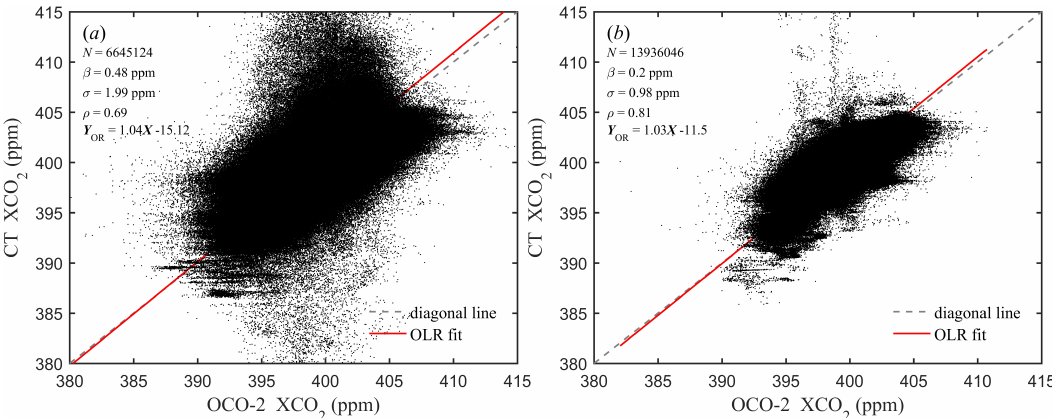
Figure 15. Scatter plots of the OCO-2 and CT XCO 2 ( a ) over land and ( b ) over the ocean. N represents the total number of OCO-2 retrievals after data quality control in